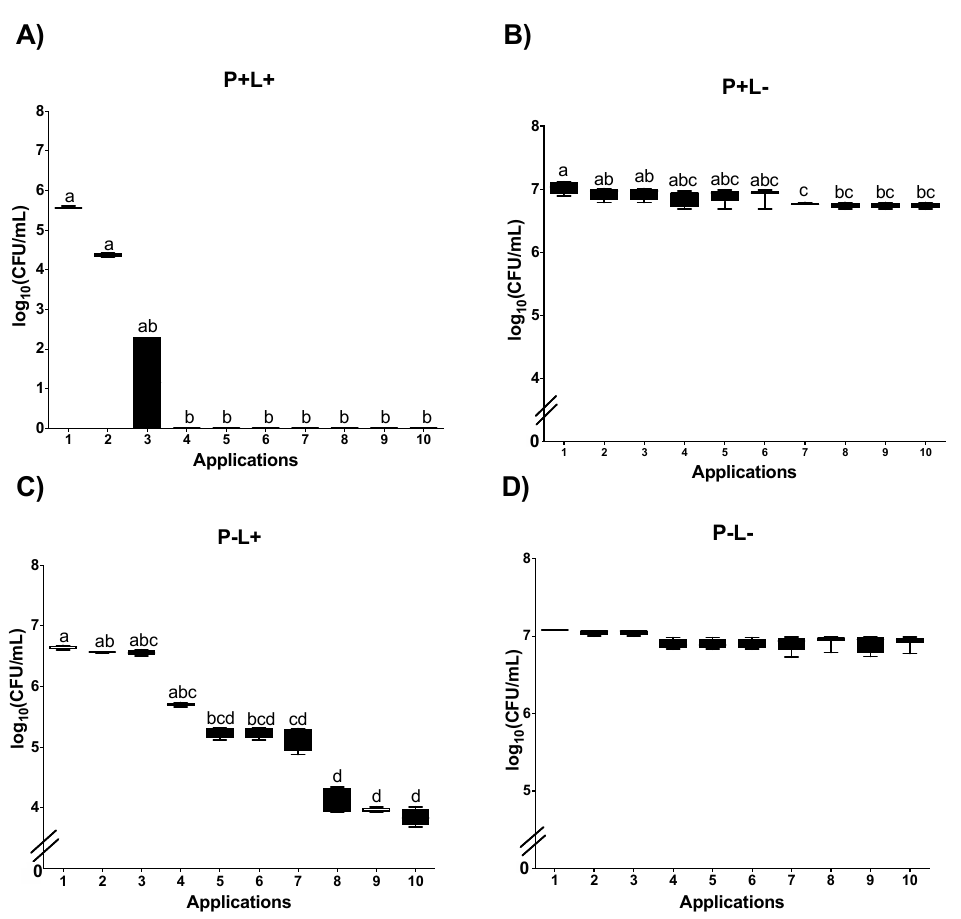
Figure 2. Log 10 values (CFU/mL) of planktonic cultures of C. albicans submitted to ( A ) aPDT (P+L+), ( B ) PDZ (P+L − ), ( C ) light (P − L+), and ( D ) control group (P − L − ). Upper limit of the box: third quartile; lower limit of the box: first quartile; error bars: minimum and maximum values. Different letters (a; b; c; d) denote statistical differences between columns (applications) according to Dunn’s post-test ( p < 0.05) ( n = 12).